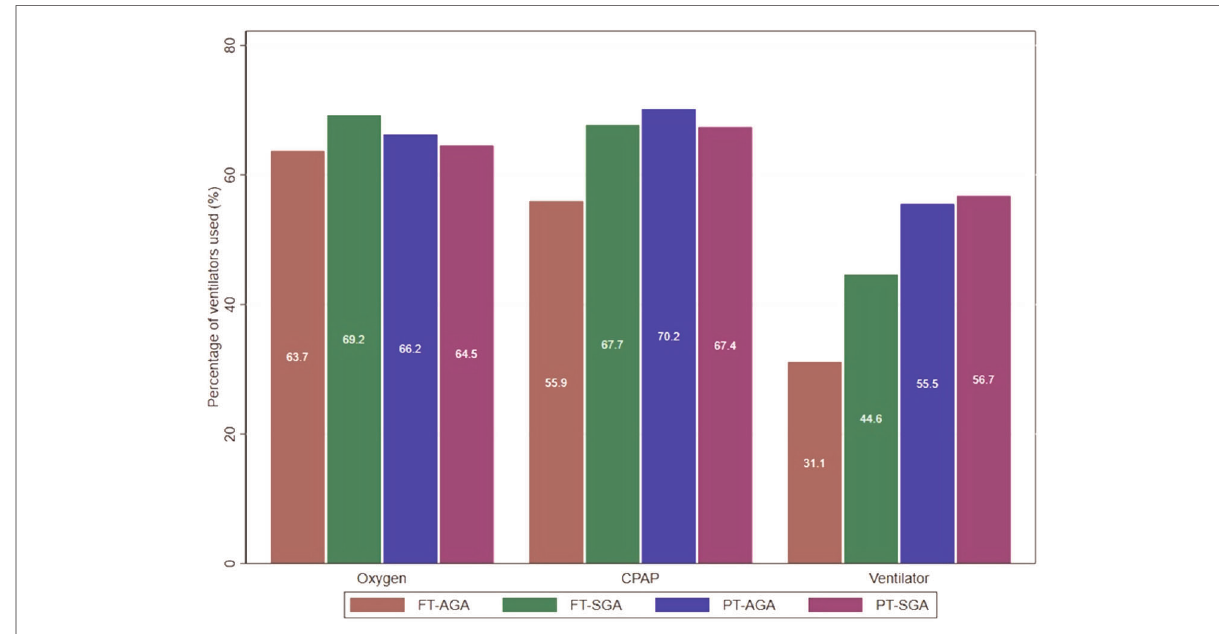
FIGURE 2 Administration of oxygen, CPAP, ventilator in four groups of full-term-preterm and AGA